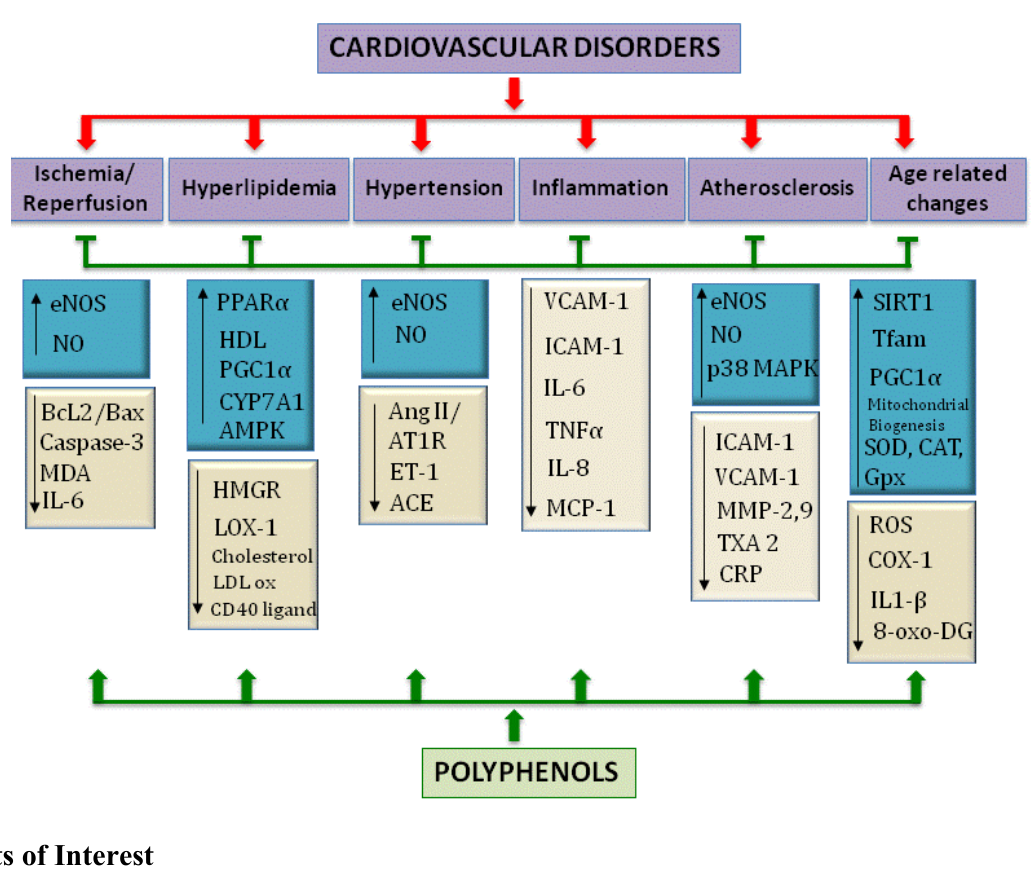
Figure 1. Mechanisms of protection by polyphenols in the cardiovascular system, in disease and in